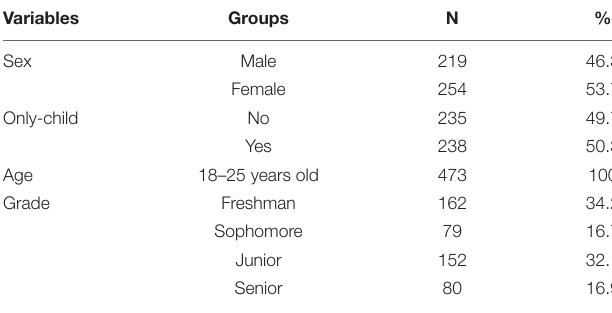
TABLE 1 | Demographic distribution of the